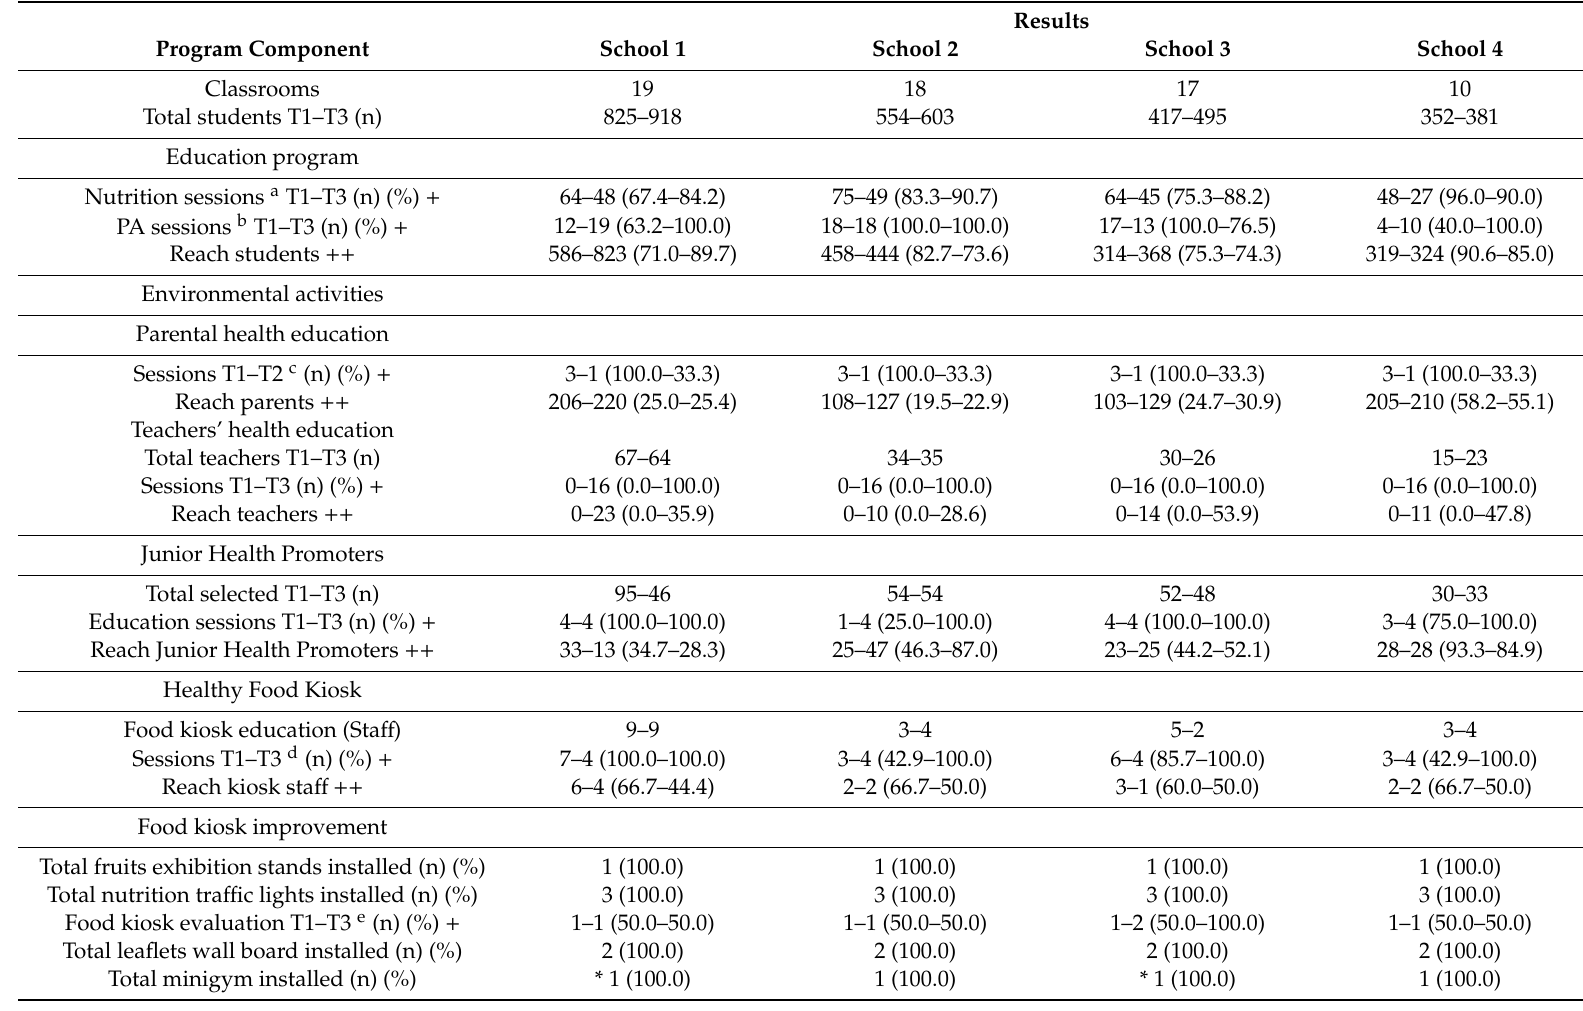
Table 4. Results in terms of Program Delivered and Reach (April 2015 to December